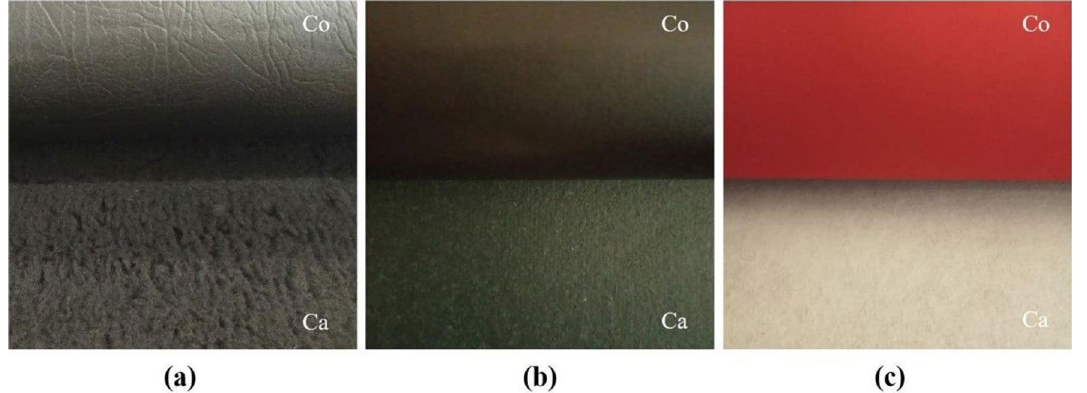
Figure 2. Tested material—artificial leather, for which samples B1 ( a ), B2 ( b ) and B3 ( c ) were collected; Co coating, Ca carrier. Source: Author’s own research.